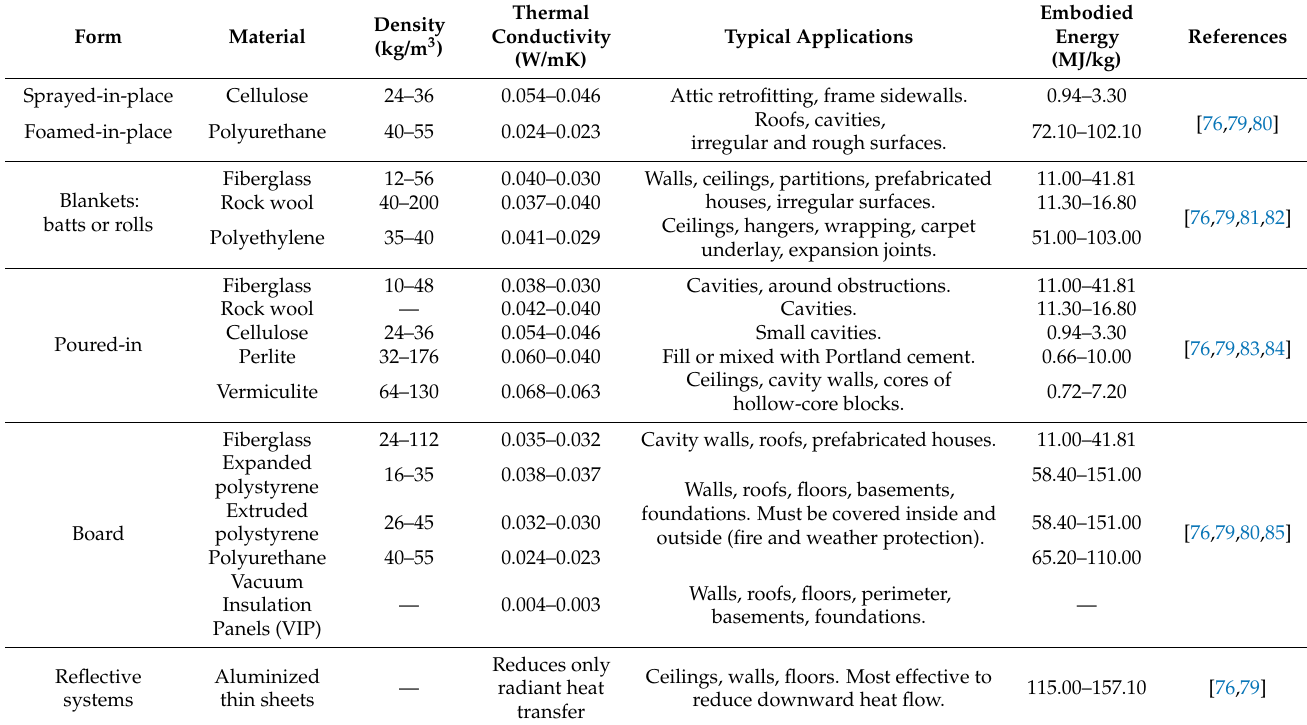
Table 2. Thermal characteristics and embodied energy of insulation